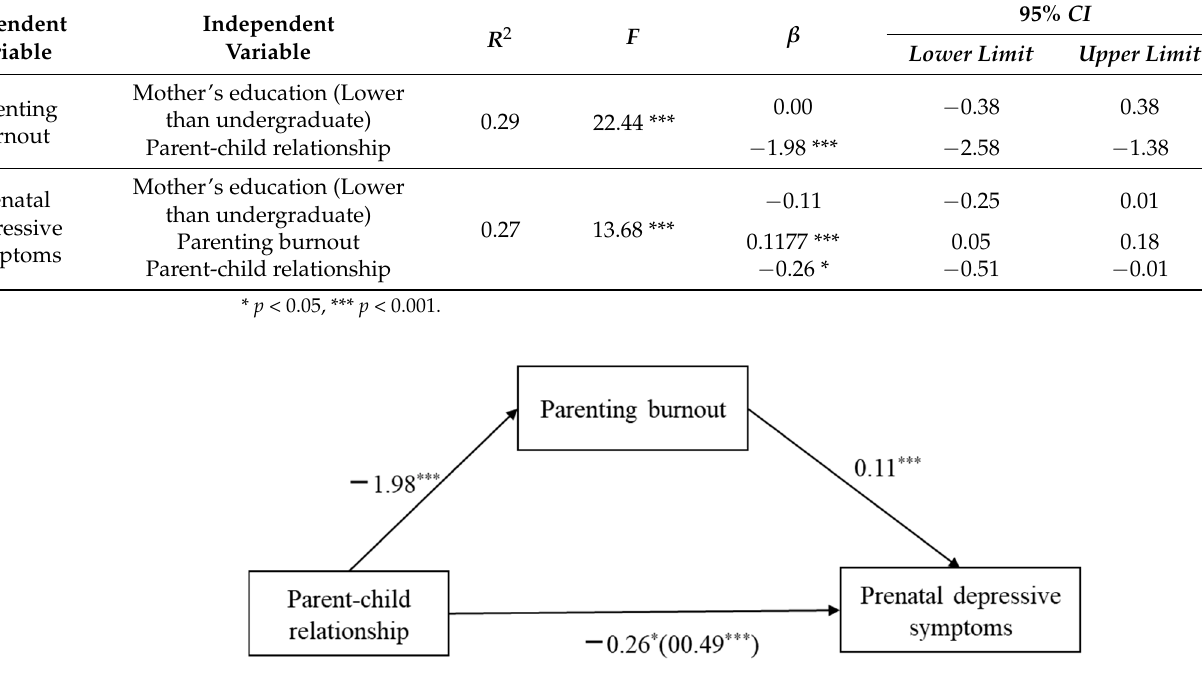
Table 5. Effect values.